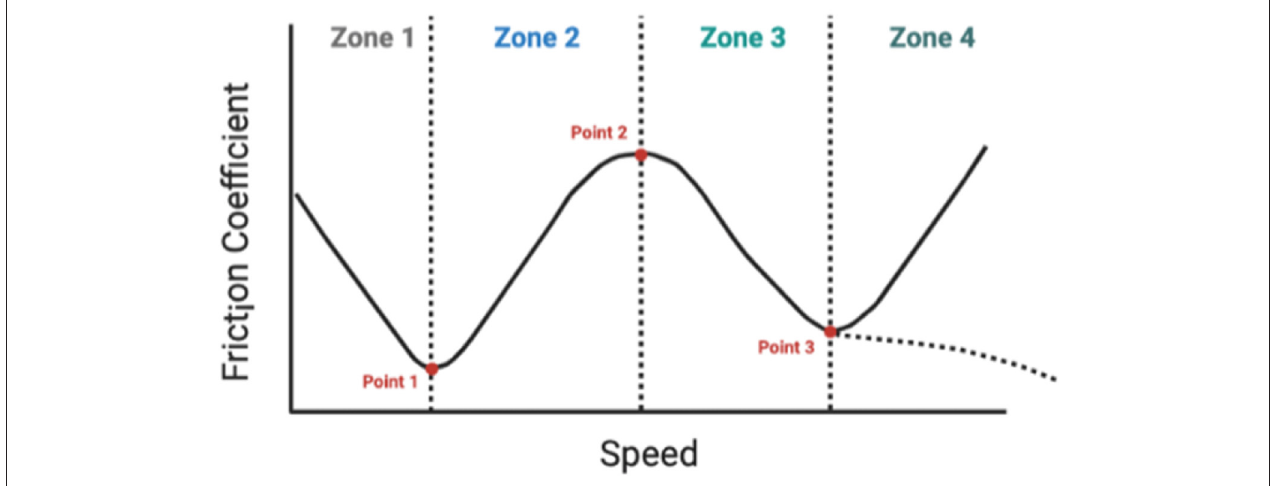
FIGURE 4 | Graph of the coefficient of friction divided into 4 zones possibly observed in dairy products. Figure edited from Nguyen et al.